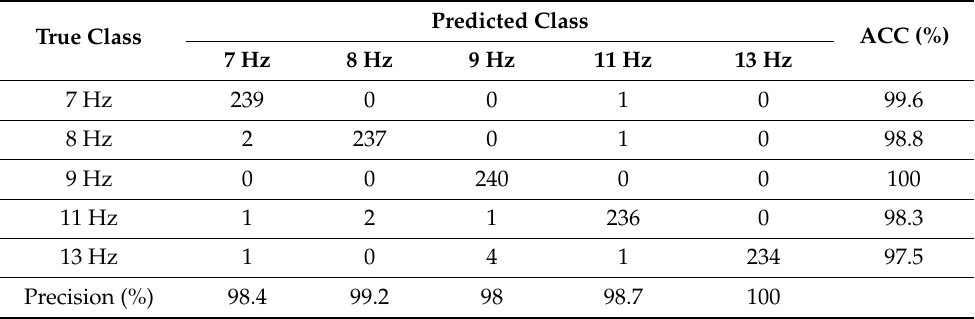
Table 9. The confusion matrix for the SSVEP recognition results using CCA classifier for the map test in the second experiment (Scenario 3).